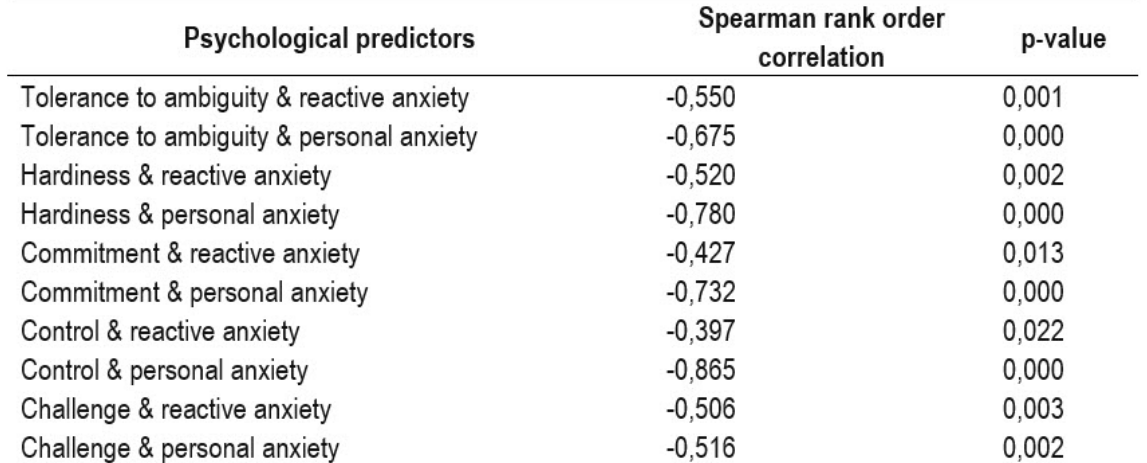
Results of statistical analysys by Spearman rank order correlation